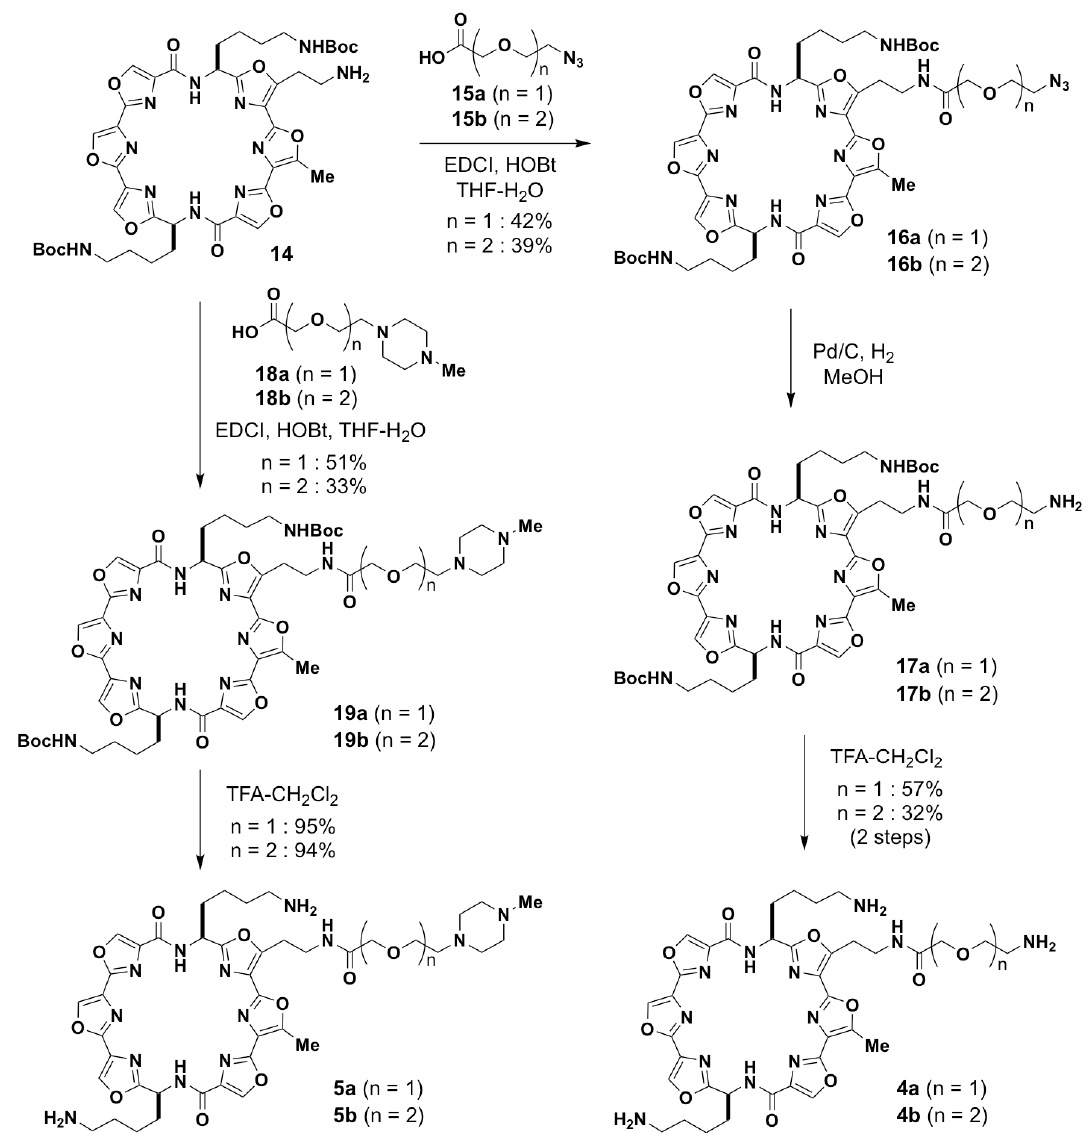
Table 1. Fluorescence resonance energy transfer (FRET) melting analysis of 6OTDs 3 – 5 (1.0 µM) with G4-forming DNA sequences (0.2 µM)